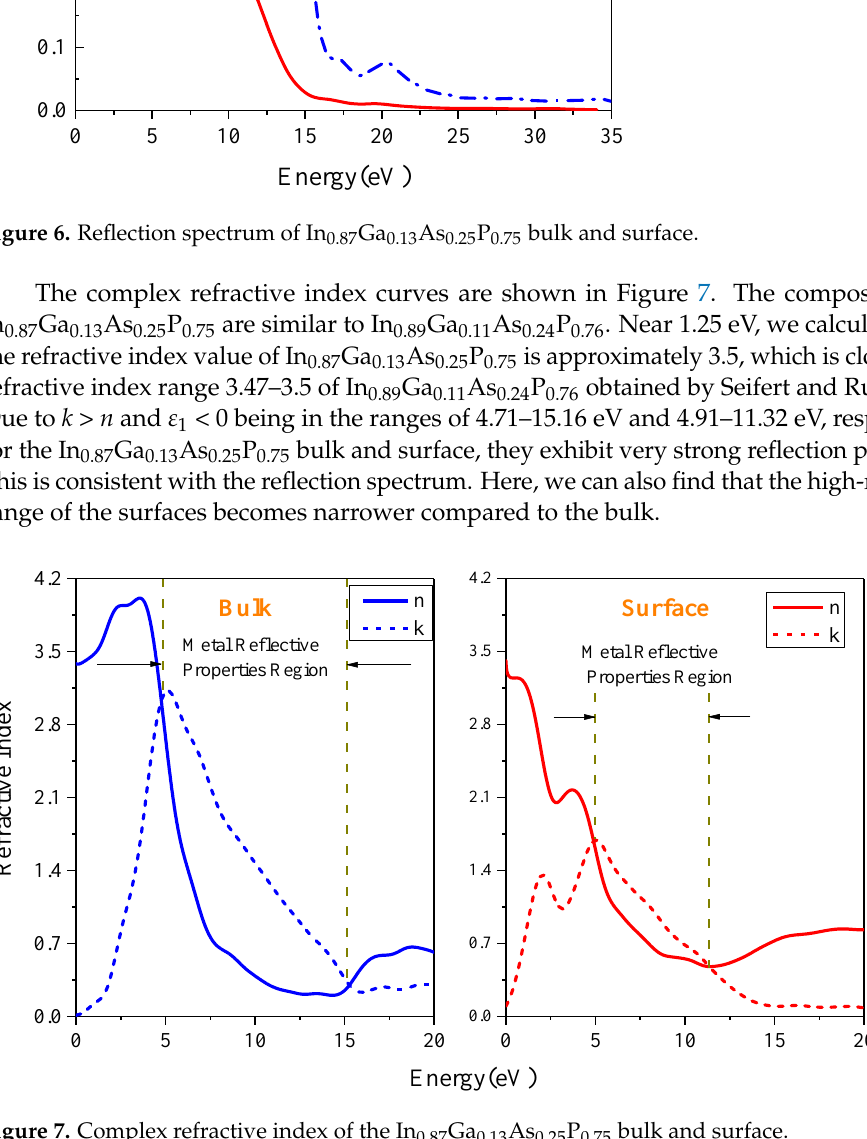
0.87 Ga 0.13 As 0.25 P 0.75 bulk and